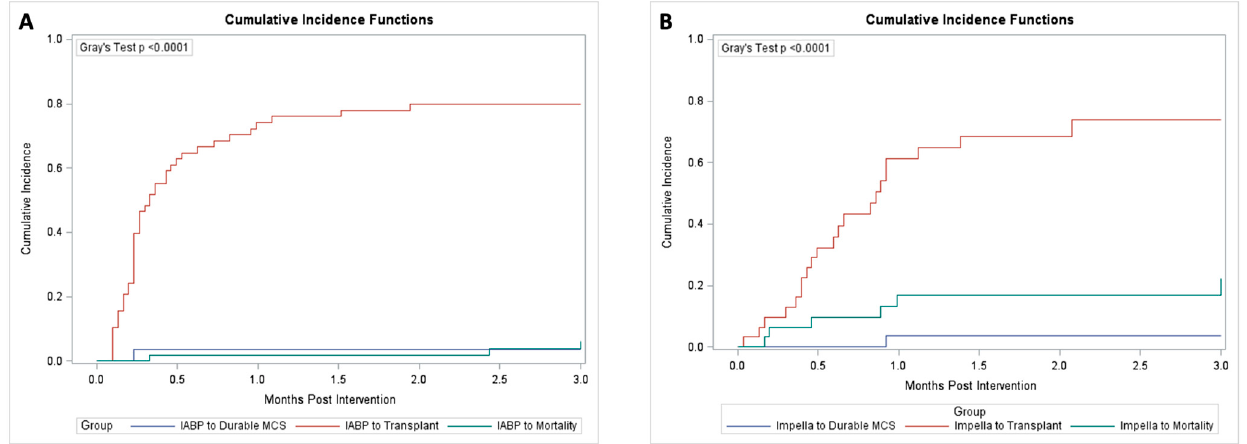
Figure 3. ( A ) Competing event model of outcomes for IABP for mortality, transplant, and durable MCS; ( B ) Competing event model of outcomes for Impella for mortality, transplant, and durable MCS.